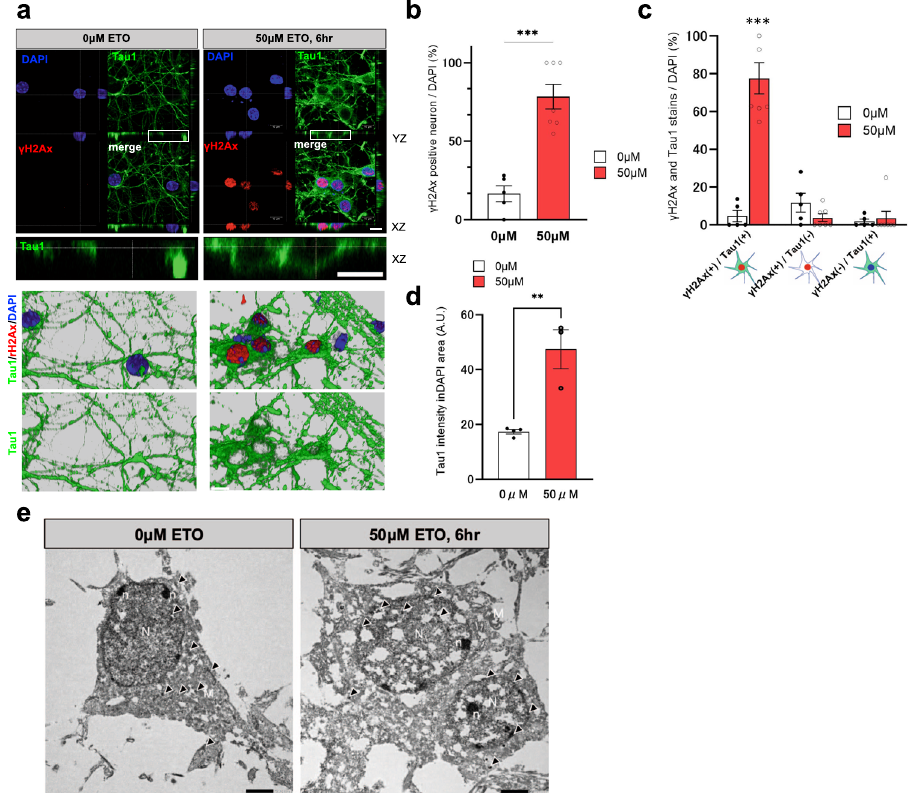
Fig. 3 Increase in non-p-tau around the nuclear membrane of neurons by DSB induction. a Top panels: Representative XY, YZ, and XZ projections of immuno fl uorescent images using antibodies against non-p-tau (Tau-1, green), γ H2Ax (red), and DAPI (Blue). Mice primary neurons were treated with 50 μ M etoposide or PBS (0 μ M ETO) for 6 h (50 μ M ETO, 6 h). White boxes show magni fi ed XZ projections of Tau-1 staining to clarify the distribution of non-p-tau. The bottom panels show 3D reconstruction images of immunostaining. Scale bar = 10 μ m. b The population of γ H2Ax-positive neurons per total neurons labeled with DAPI in non-treatment (white column, n = 5) and 50 μ M etoposide-treatment for 6 h (red column, the number of images examined = 7). n : number of images examined; ** p = 0.0001, The p -value was obtained by Student ’ s t test. c Quanti fi cation shows that the percentage of cells with Tau-1- γ H2Ax double-positive neurons were exclusively high in 50 μ M etoposide treatment ( γ H2Ax + /Tau-1 + ). Statistical signi fi cance was determined by two-way ANOVA followed by a Tukey test. n : number of images examined. *** p < 0.0001. d Quanti fi cation of the Tau-1 intensity in DAPI area. White column is non-treatment ( n = 4), red column (n = 3) is 50 μ M etoposide treatment for 6 h. n: number of images examined; ** p = 0.0041, The p -value was obtained by Student ’ s t test. e Immunogold electron micrographs in non-p-tau labeled with Tau-1 antibody from primary mouse cortical neurons with non-treatment (0 μ M etoposide) and 50 μ M etoposide treatment for 6 h Arrowheads indicate labeling the gold particles for Tau-1. N nucleus, n nucleolus, M mitochondria. Scale bar = 2 μ